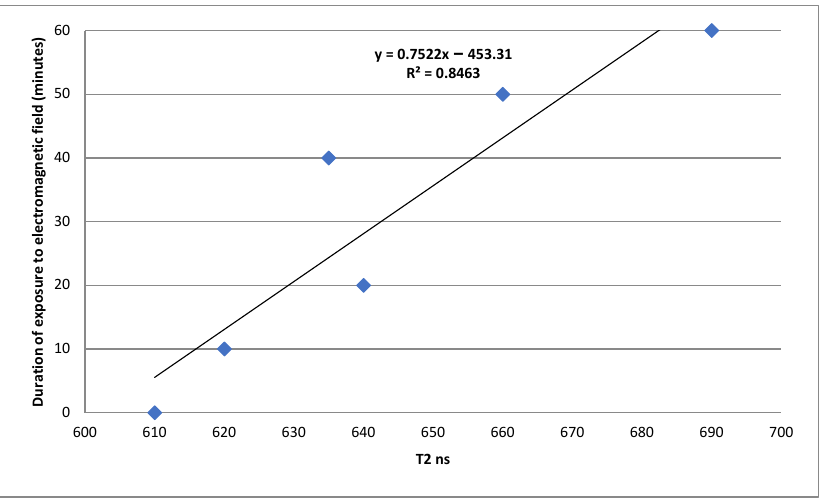
Figure 12. Electronic relation time T 2 plotted against the electromagnetic exposure time of oil.